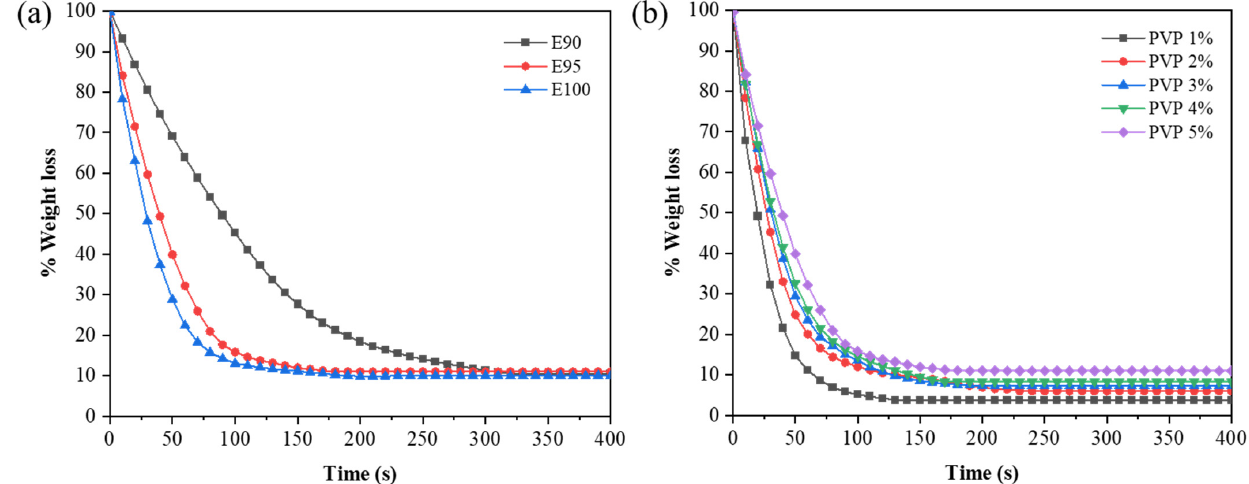
Figure 1. Evaporation rates of PVP solutions at different ( a ) solvent ratios and ( b ) polymer concen-